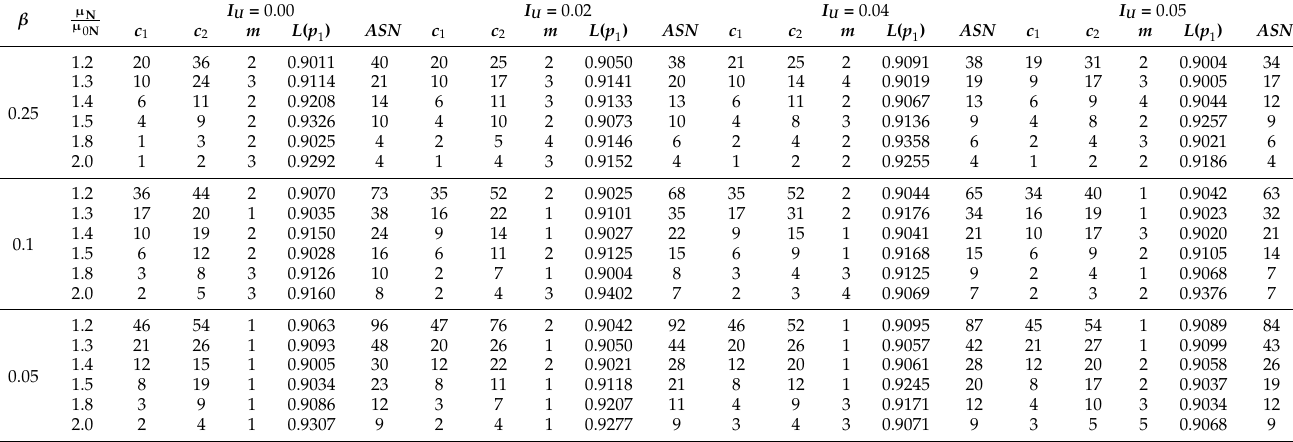
Table 6. The MDS design values for α = 0.10, ν = 3, and a =